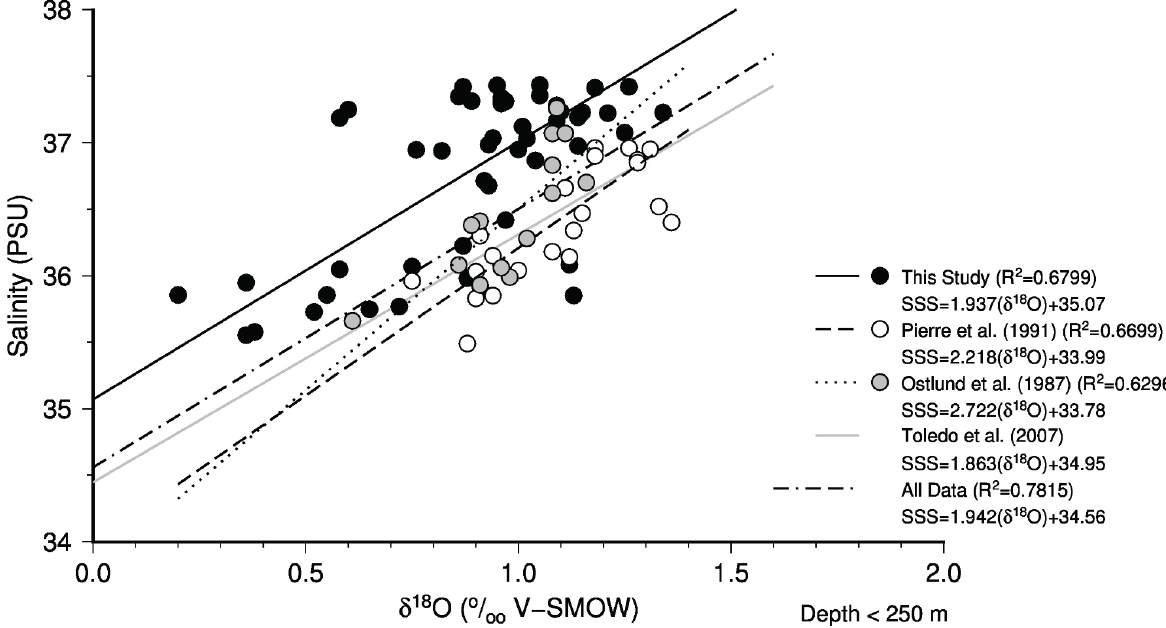
and salinity, and compared with Pierre et al. (1991), Ostlund et sw